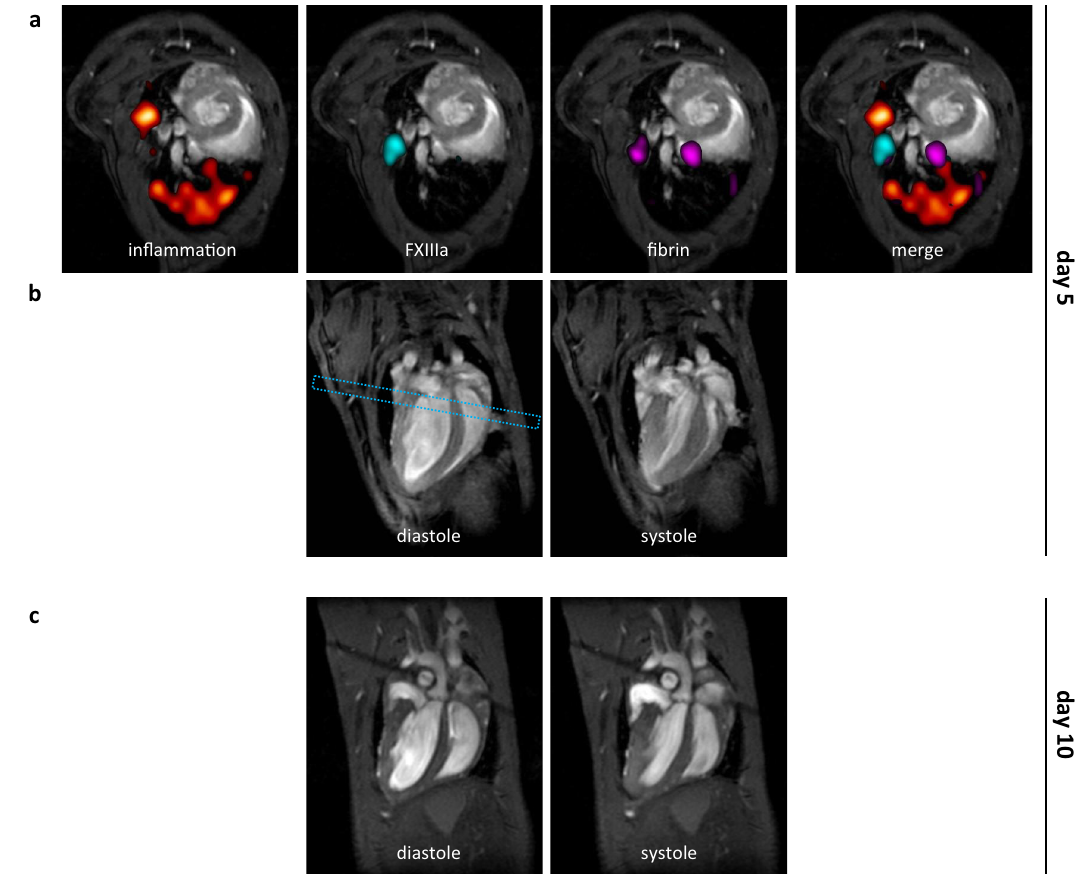
Fig. 4 Premature detection of pulmonary in fl ammation and thrombosis turns into right heart failure. Multi-targeted PFCs for detection of in fl ammation (red), FXIIIa (cyan) and fi brin (magenta) in the same mouse 5 days (a + b) and 10 days (c) after onset of the diet. a 19 F mCSSI data are superimposed over anatomical 1 H MRI data (greyscale) and fi rst investigation on day 5 indicated differentially affected tissue sites mainly in pulmonary areas with b normal function in long axis views in diastole and systole (LVEF 70.4%, RVEF 71.1%). The dashed rectangle indicates the perpendicular view shown in a. c Follow- up on day 10 revealed that preceding pulmonary thromboin fl ammation (a) leads to severe right ventricular impairment (LVEF 54.6%, RVEF 17.8%).